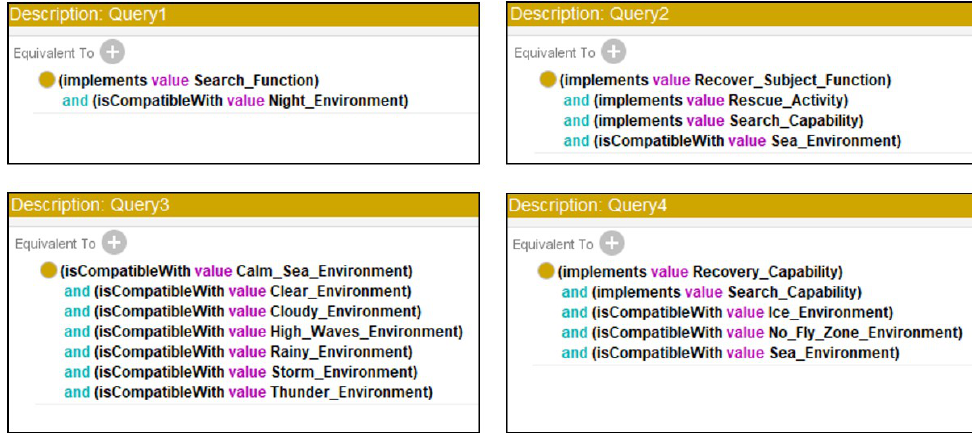
Figure 17. The definitions for the four different user-defined